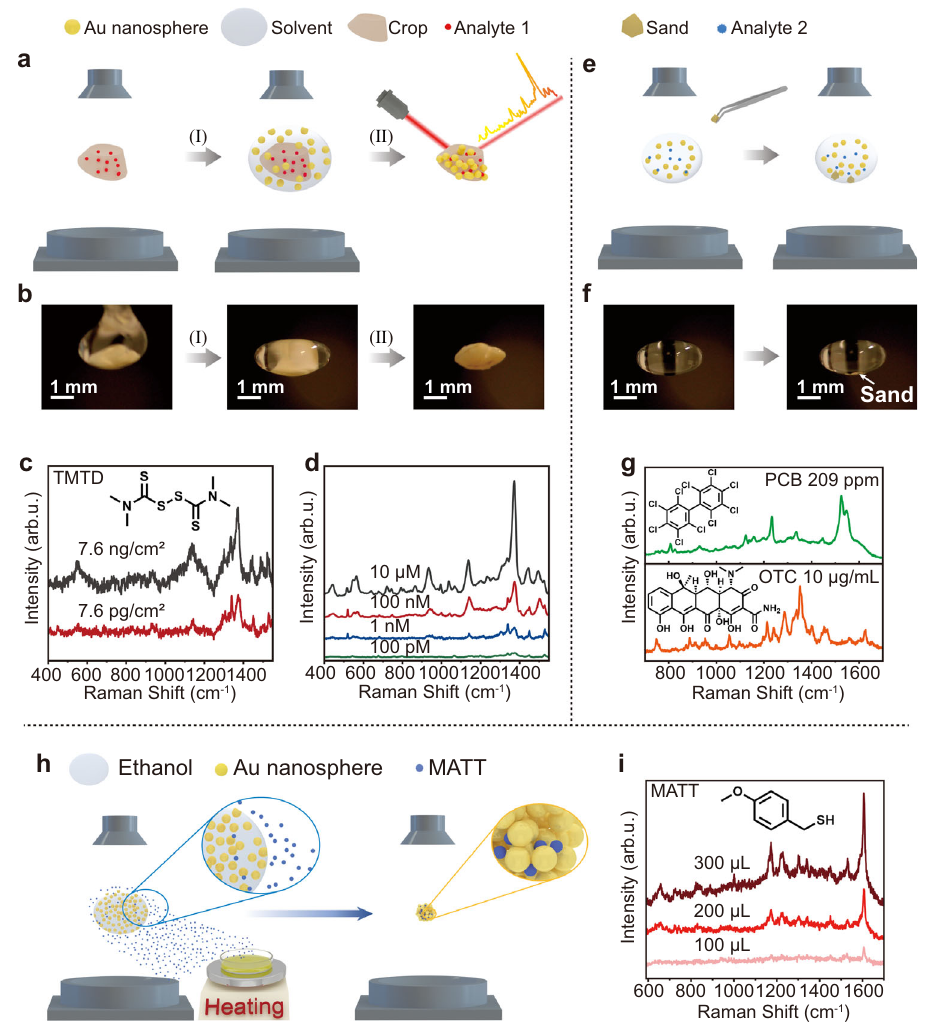
Fig. 4 | Direct SERS detection of analytes on solid objects and in air using the DLEplatform.a , b Schematicandexperimentalresults,respectively,ofdirectSERS detection of pesticides on a sesame-seed slice using the DLE platform. Process I in ( b ). Introducing Au nanoparticle colloids onto a levitating sesame-seed slice (long axis: ~2.18mm). Process II in ( b ). After solvent evaporation, SERS measurements were performed. c SERS spectra of TMTD pesticide at different